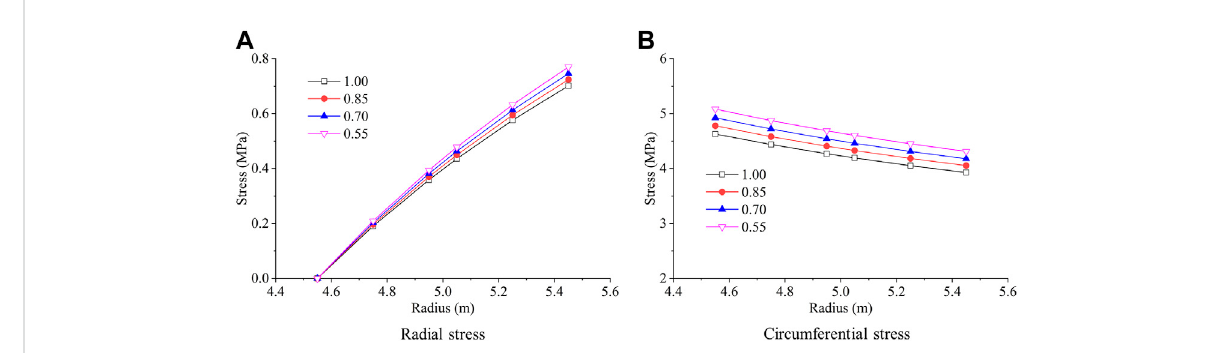
FIGURE 10 In fl uence of deterioration coef fi cient k d under state TU.